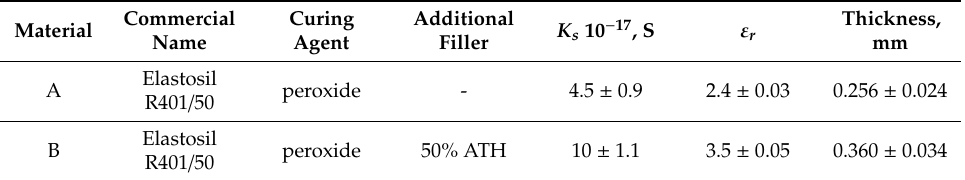
Table 1. Specification of the studied materials, measured surface conductivities K s (at 1 kV), dielectric constants ε r (at 50 Hz) and thickness of the